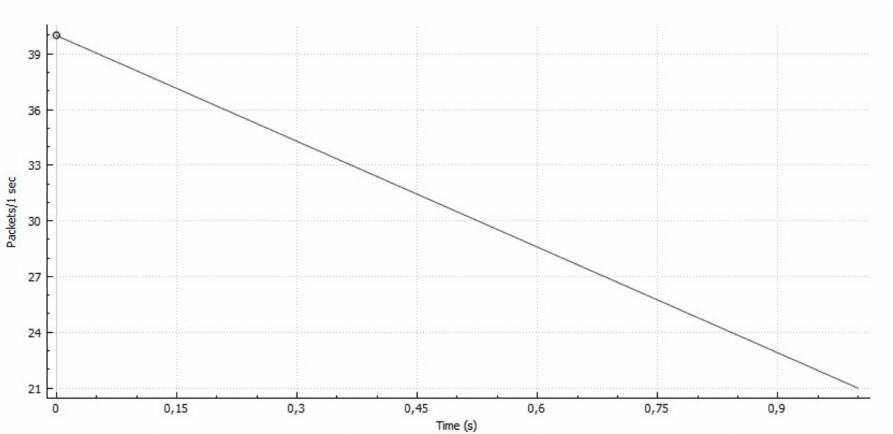
Figure 7. A diagram of the packet tra ffi c load after synchronization and mining.